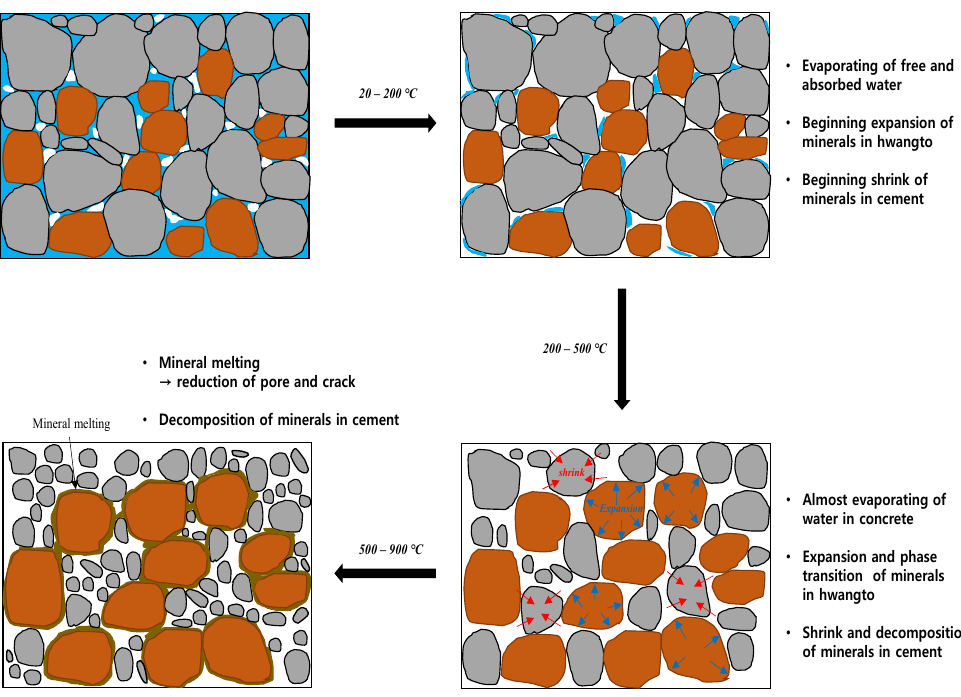
Figure 1. Mechanism of hwangto in concrete at high temperatures.